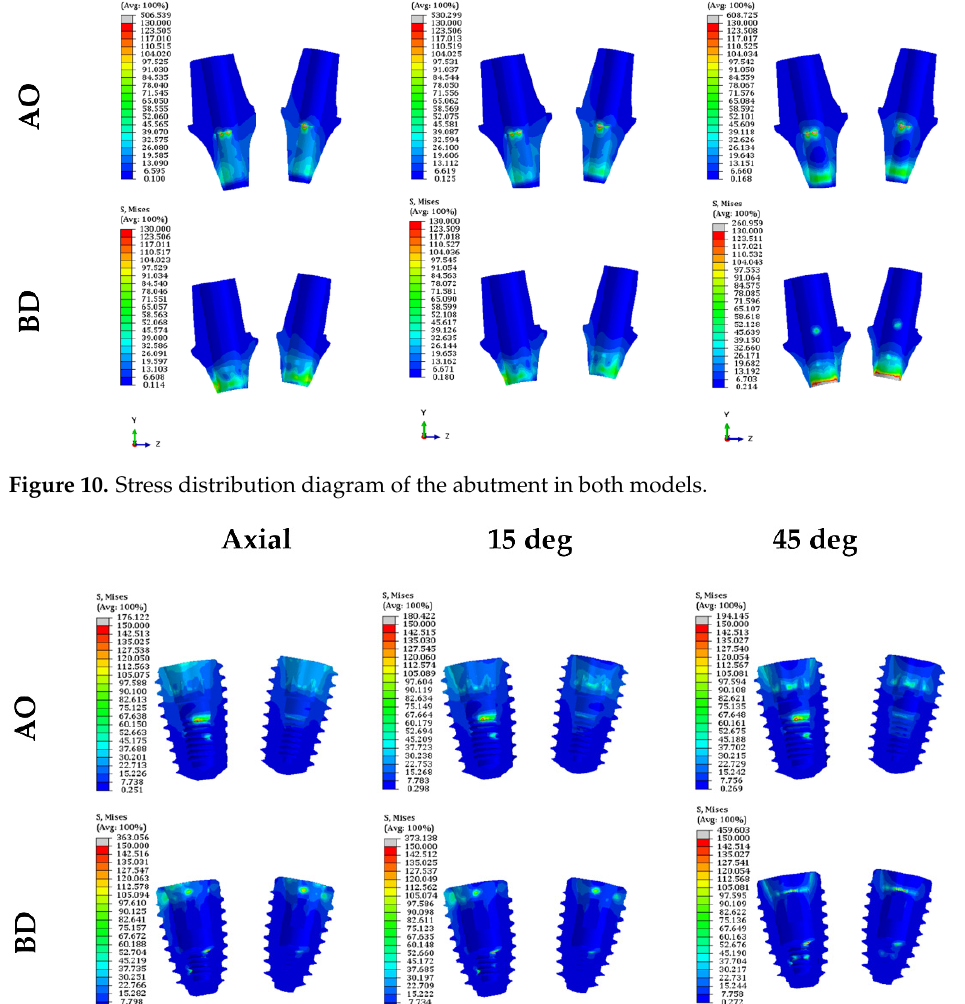
Figure 11. Stress distribution diagram inside the fixture of both models.